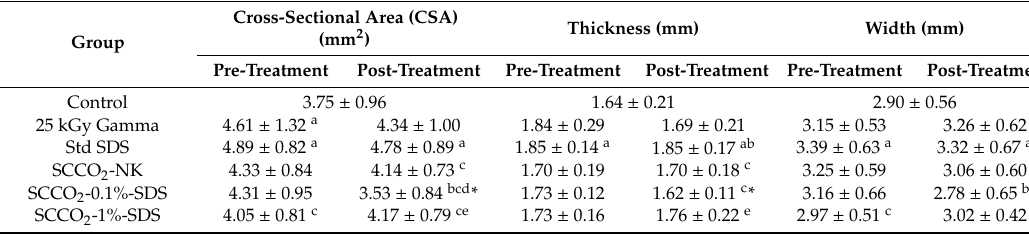
Table 1. Pre- and post-treatment dimensions.